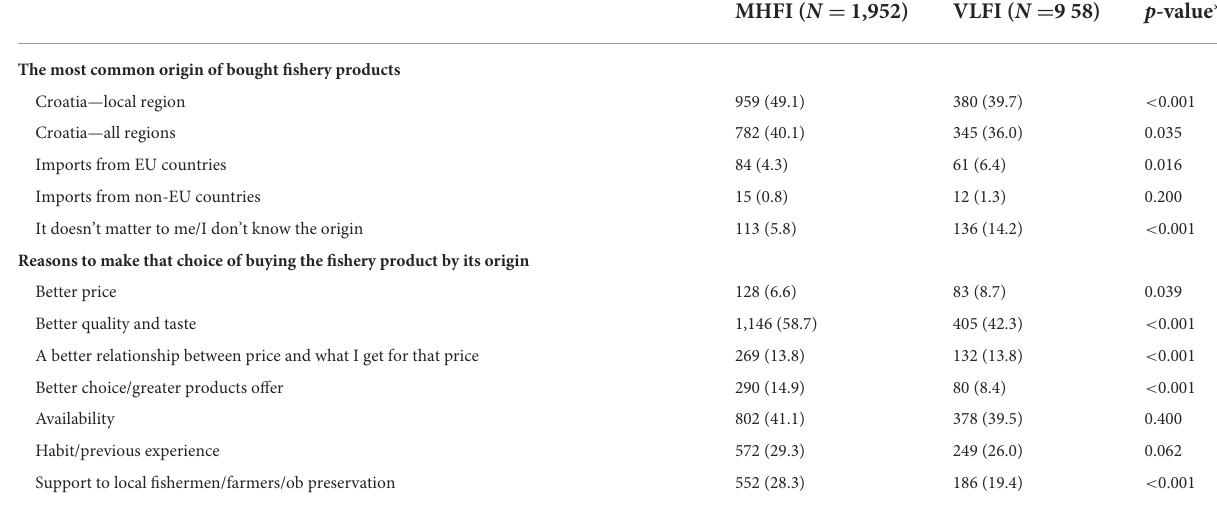
TABLE 4 Choices and reasons to buy fishery products by its origin ( N = 2,910) among groups regarding the recommended fish